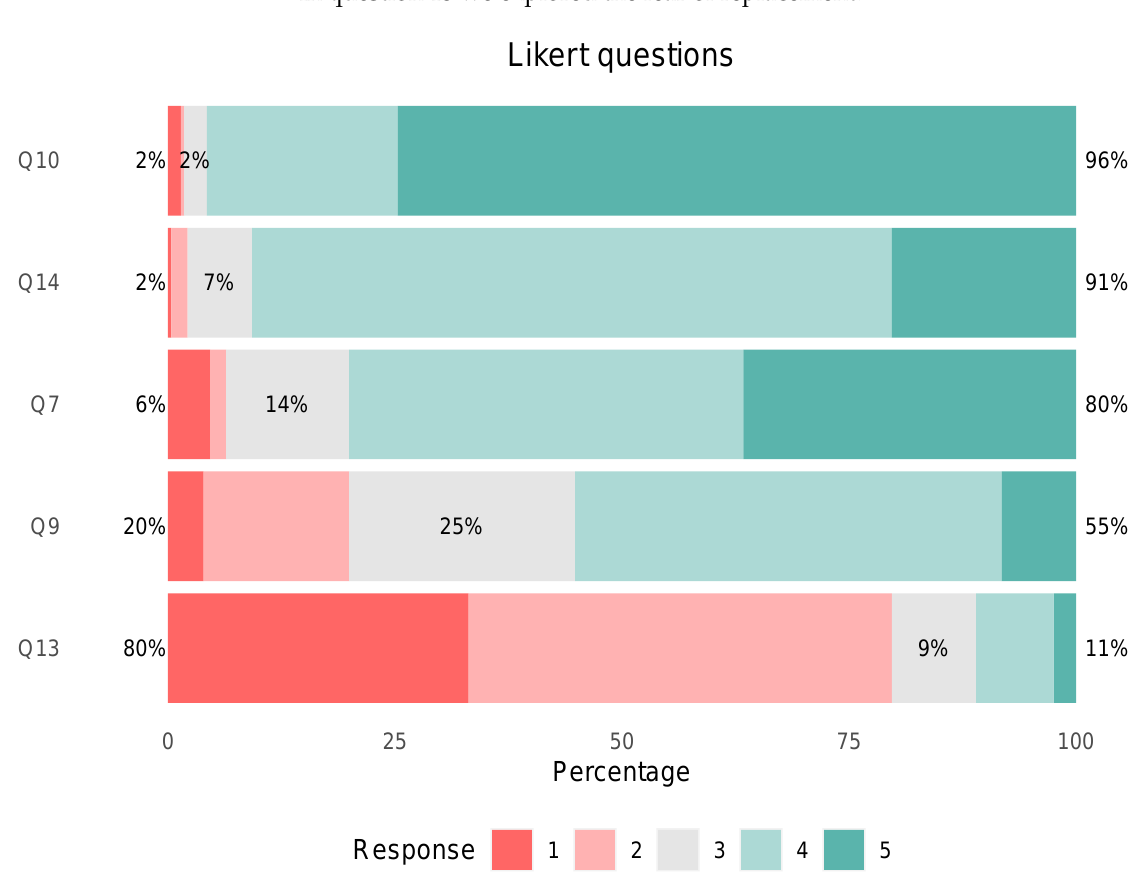
Figure 2. Analysis of Likert questions with horizontal bar chart. A high percentage of agreement (Agree and Totally agree) in ethics, education and impact of AI in radiology was observed. A high percentage of disagreement 80% (Disagree and Strongly disagree) was about the fact of radiologists being replaced by AI. Abbreviations used in Figure 2 due to their length: Q10 (Do you think AI should follow ethical principles?); Q14 (Will the way radiologists work change with the impact of AI?; Q7 (Do you think that students should be trained in the use of AI?); Q9 (Do you think AI can affect human autonomy by interfering with decision-making?); Q13 (Do you think the rise of AI could replace radiologists?). Response: 1= Strongly disagree; 2= Disagree; 3= Neither agree/Nor disagree ; 4= Agree ; 5 = Totally Agree.